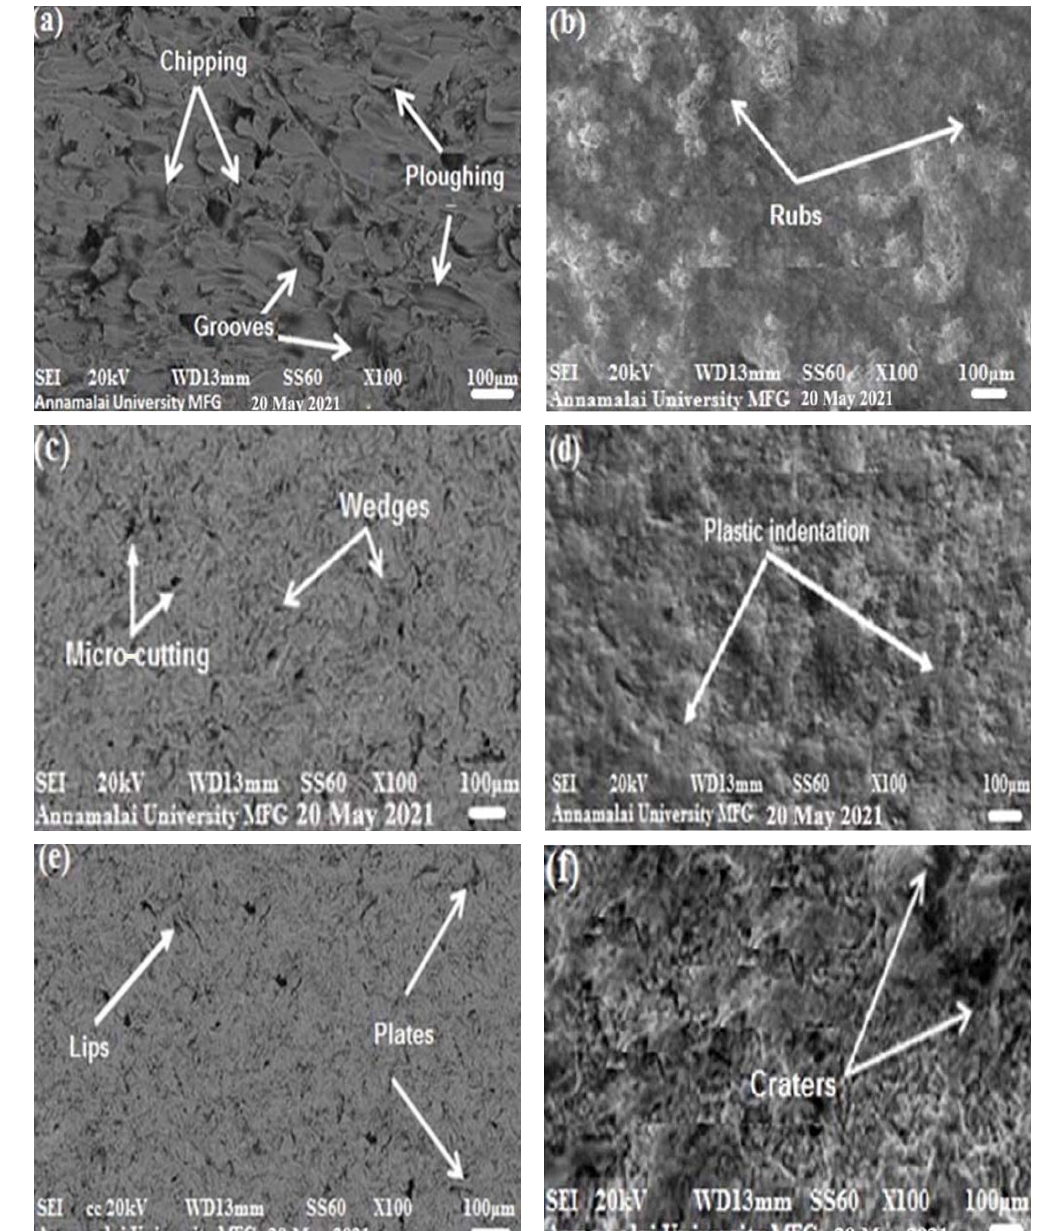
Figure 7. Worn surfaces of the coatings and substrate at different water jet velocities: ( a , c , e ) uncoated substrate; ( b , d , f ) coatings.